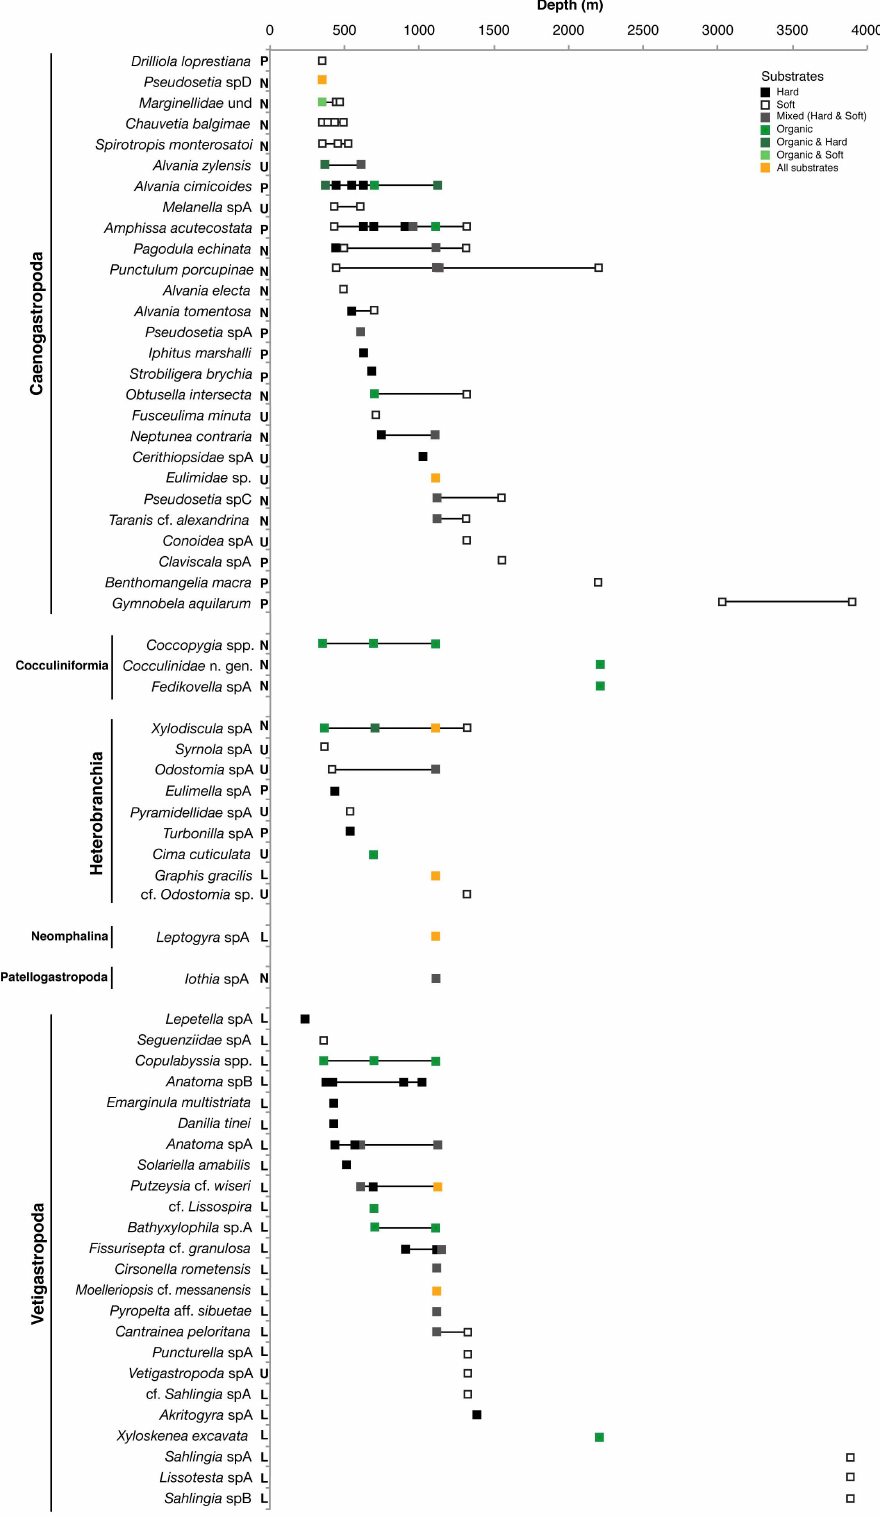
Fig. 2. Bathymetric distribution of the gastropod taxa collected in the Gulf of Cadiz. Type of larval development is indicated after each taxon’s name. P: planktotrophic; L: lecithotrophic; N: non-planktotrophic; U: unknown. Data from all samples and experiments are